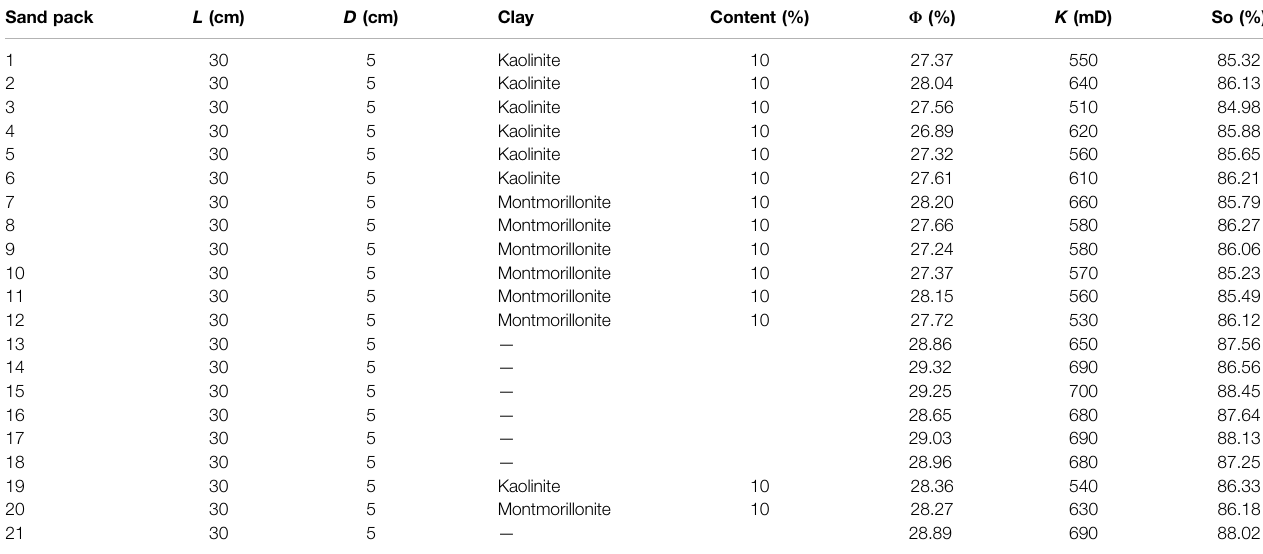
TABLE 4 | Sand pack properties.